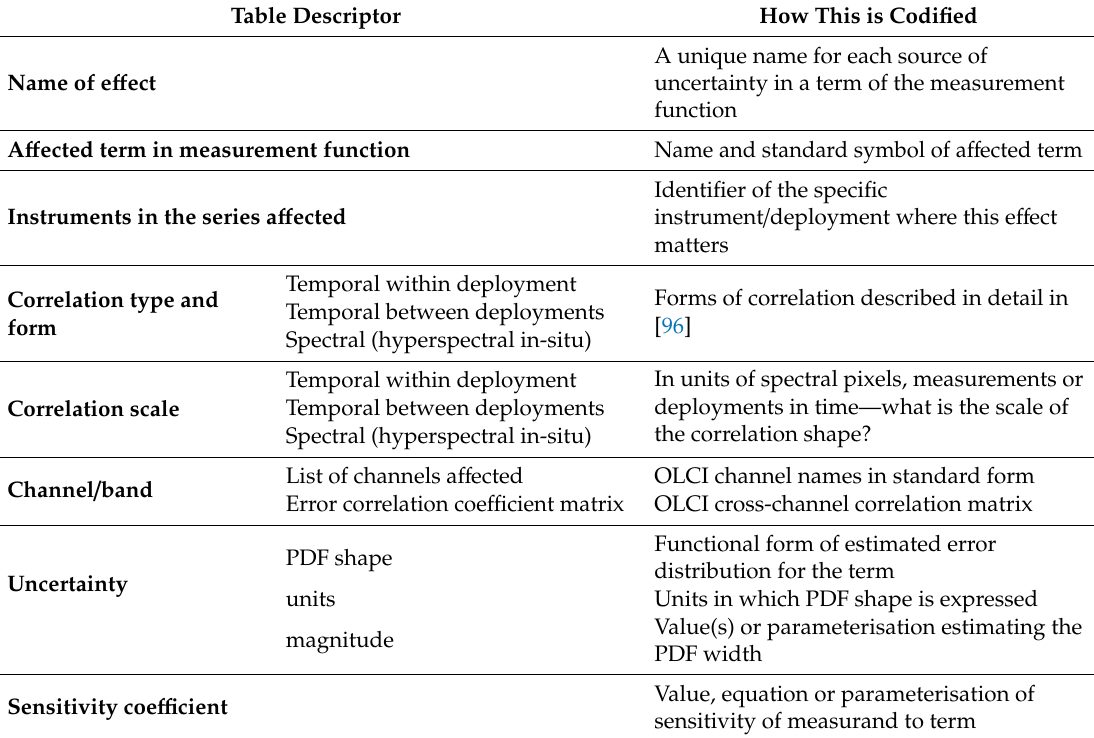
Table 6. Table for codifying the uncertainty due to an error e ff ect and its correlation structure. Table Descriptor How This is